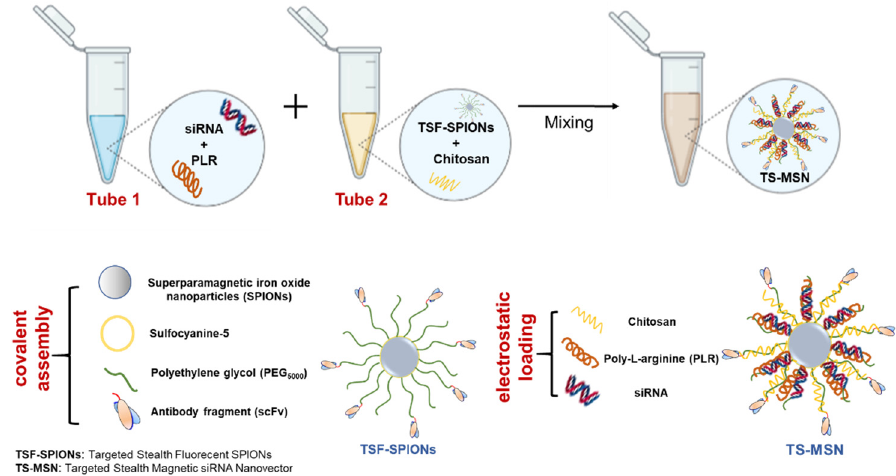
Figure 1. Schematic illustration of the TS-MSN formulation protocol .